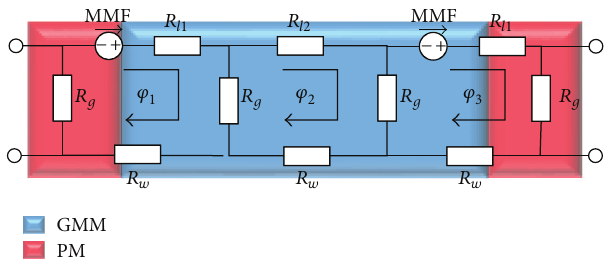
Figure 2: 3D diagram for an element and its equivalent magnetic